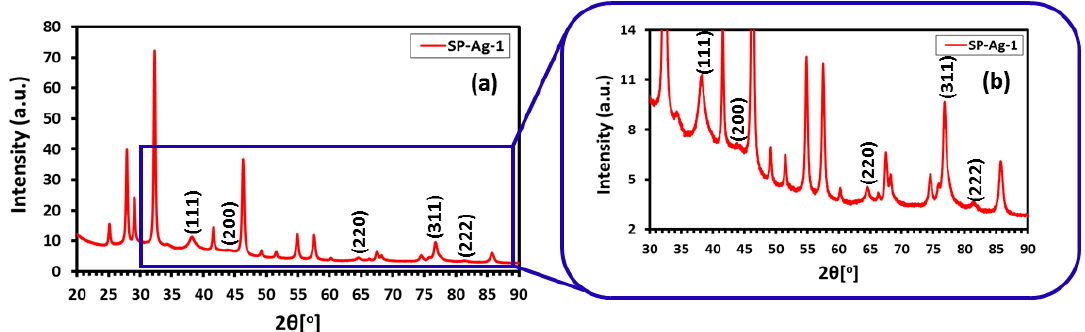
Figure 5. ( a ) X-ray diffraction (XRD) diffractogram of SP-Ag-NPs; ( b ) Magnified image of Figure 5a.